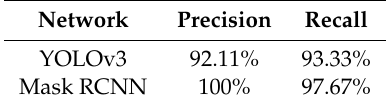
Table 6. Precision and recall of four different networks on simulation